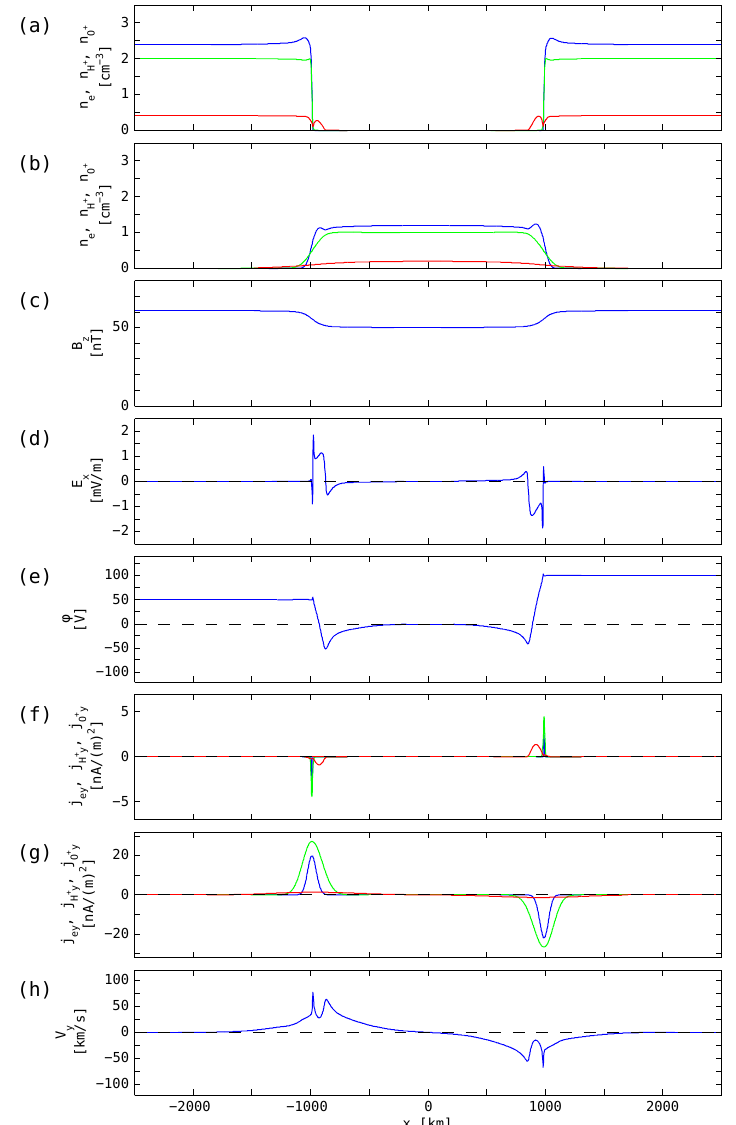
Fig. 5. Plasma and field structure of a 2000km-wide e − -H + -O + plasma slab embedded in a uniform background. The plasma parameters are given in Table 1. There is no cross-field flow at the slab centre, V 0 y = 0. The electric potential boundary conditions are φ( −∞ ) = 50V and φ( +∞ ) = 100V. The figure format is the same as in Fig.